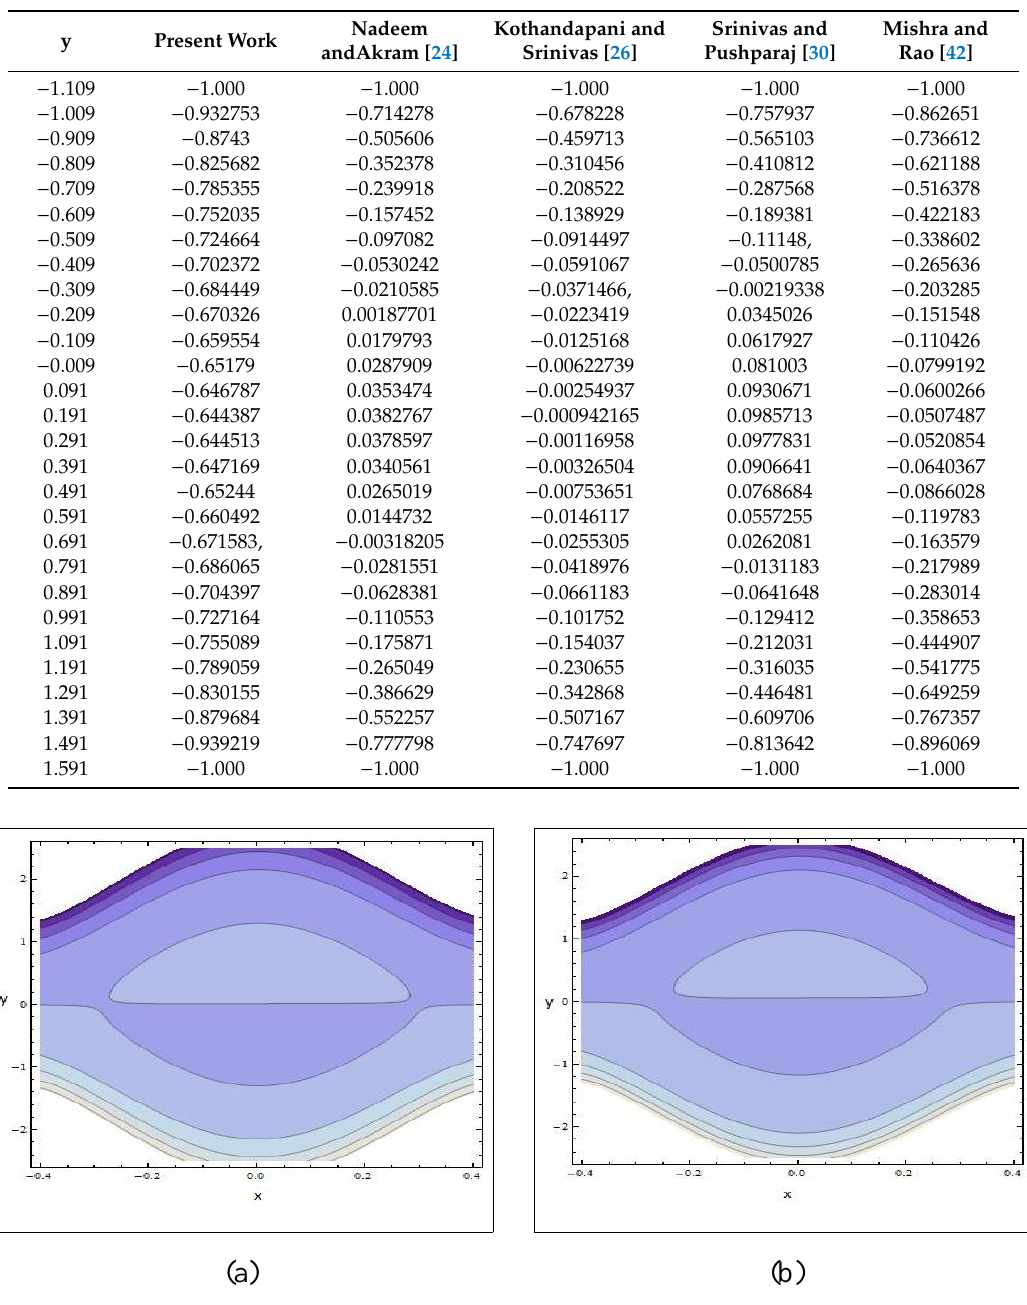
= 0.1, ( b ) for λ = 1.6. The other . ( a ) for λ 1 1 1 π = 0.009, η = 0.001, , M = 2.2, ϕ = 0.01, η 5 1 2